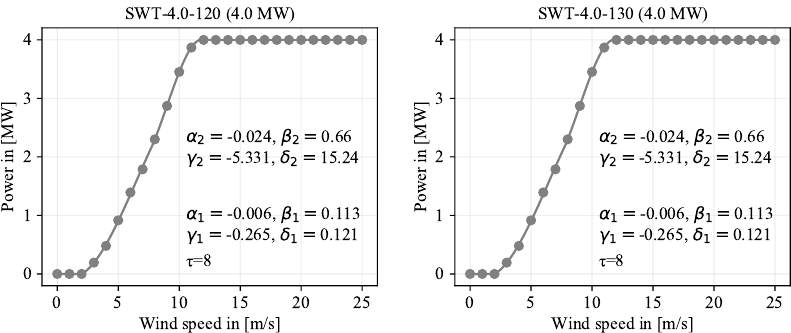
( f ) Power curve of wind turbine SWT-4.0-130.